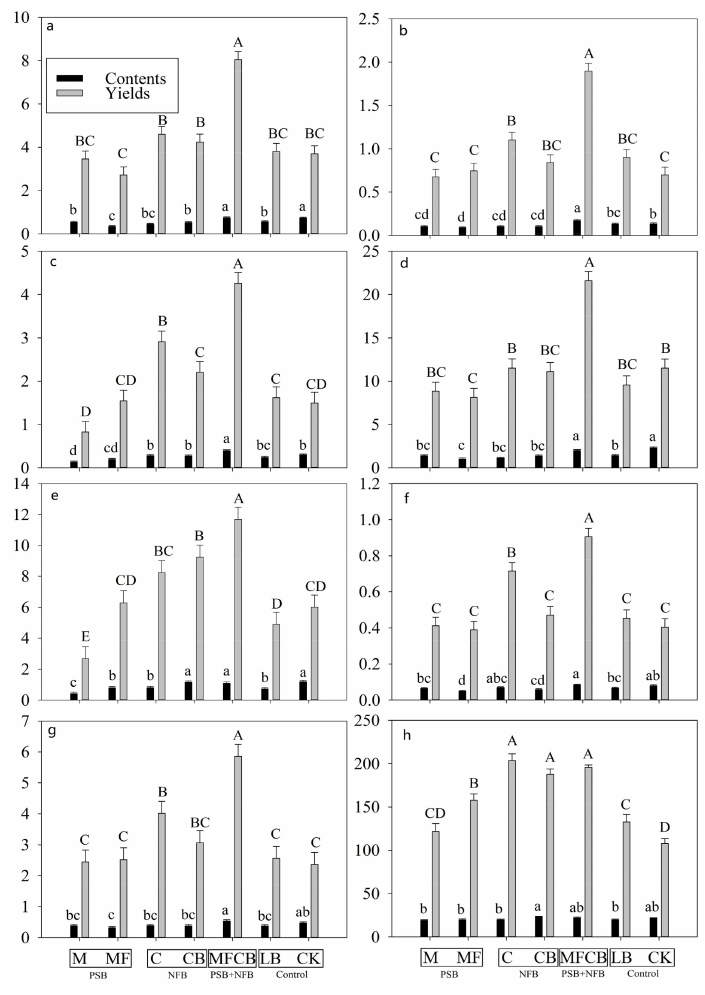
Figure 4. Concentrations (mg · g − 1 ) and yields (mg · plant − 1 ) of seven flavonoid monomers and total flavonoid. ( a ): quercetin-3-O-glucuronide; ( b ): quercetin-3-O-galactoside; ( c ): isoquercitrin; ( d ): kaempferol-3-O-glucuronide; ( e ): kaempferol-3-O-glucoside; ( f ): quercetin-3-O-rhamnoside; ( g ): kaempferol-3-O-rhamnoside; ( h ): total flavonoid. Same as follows. Di ff erent lowercase / capital letters denote significant di ff erences in concentration / yield among treatments at p <